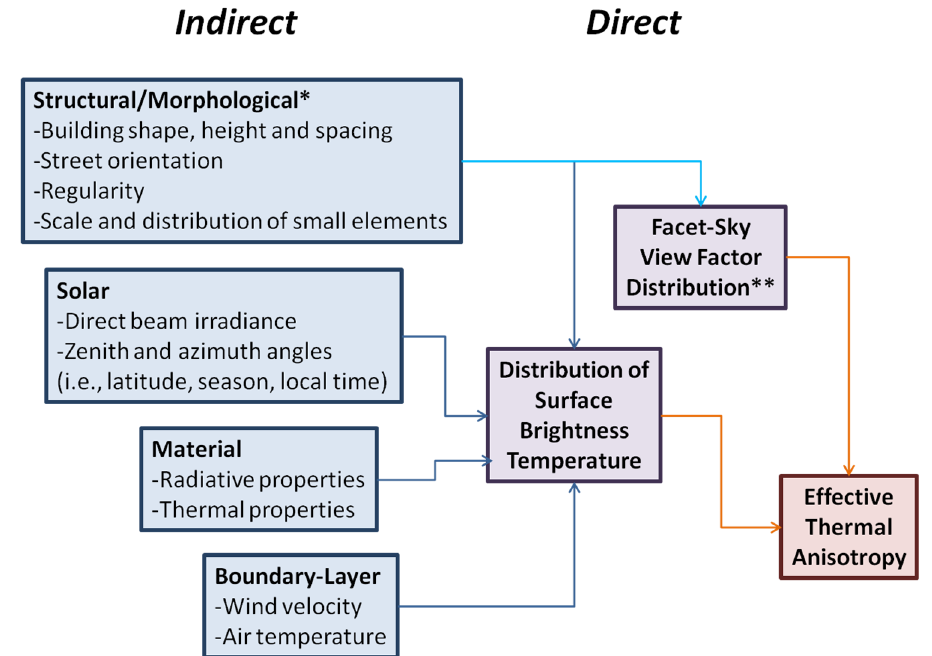
Figure 1. Conceptual diagram elaborating the indirect and direct factors that drive and modulate effective thermal anisotropy, and their relatedness. * The only “indirect” factor that affects facet-sky (or sensor-facet) view factors; ** Effective thermal anisotropy is observed by limited fields of view (FOV) sensors, in which case the facet-sky view factor distribution underlies the variation of sensor-facet view factor with sensor view angle.